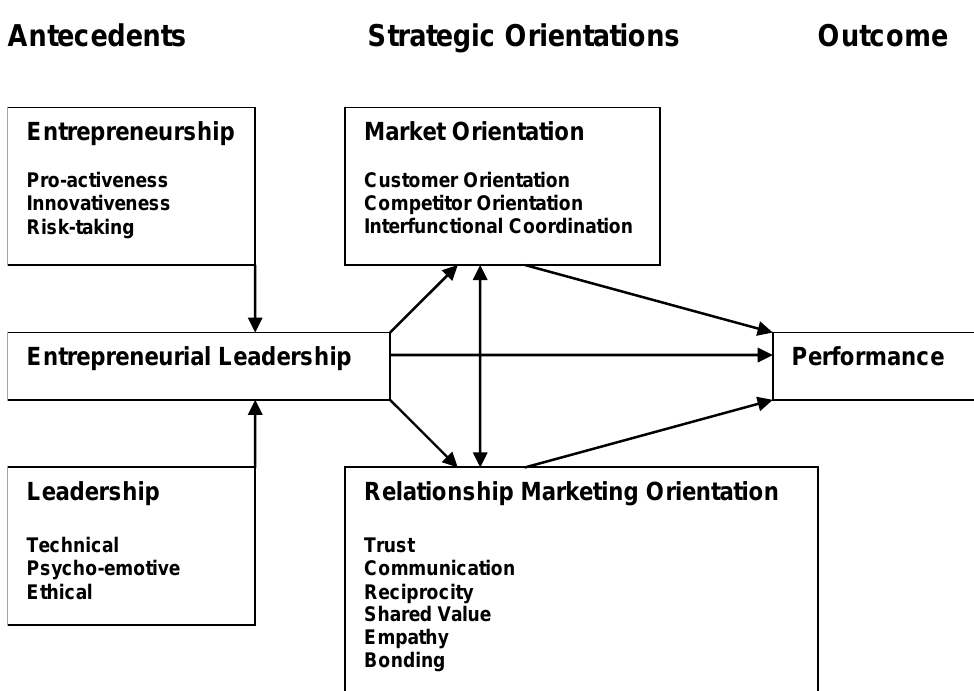
Figure 1: Conceptual model: Linking entrepreneurial leadership with market orientation, relationship marketing orientation and